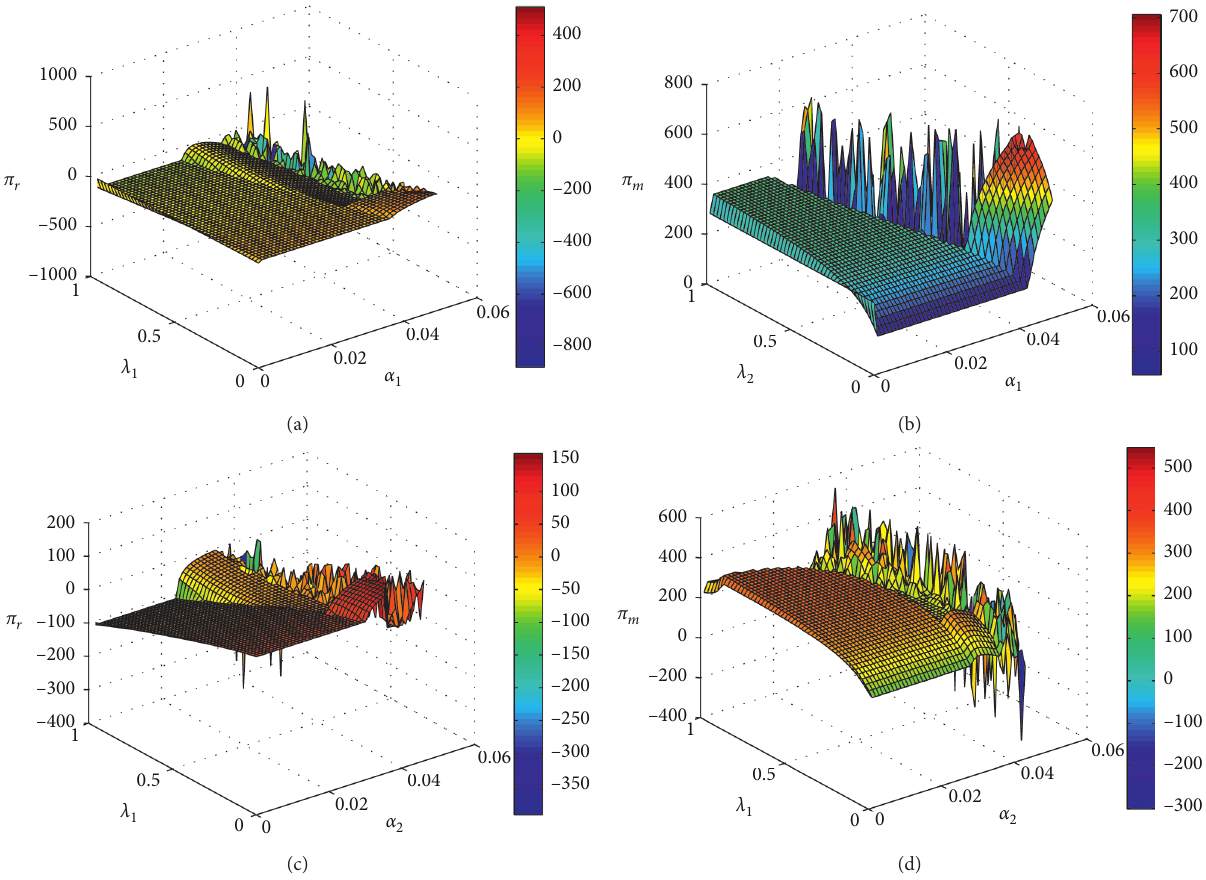
Figure 11: Change of profits with respect to α (b) Change of profits of the retailer with respect to α of the manufacturer with respect to a